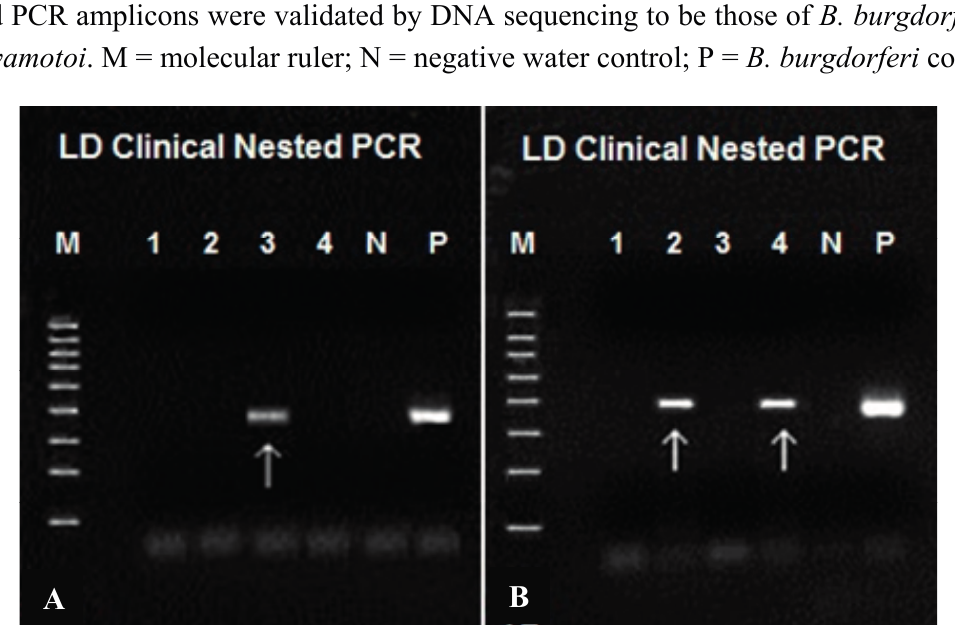
density. The DNA of the spirochetes pelleted from 1 mL of platelet-rich plasma of the patients was extracted and reduced to 100 µL in volume. One µL of the latter crude DNA concentrate was used to initiate each M1/M2 same-nested PCR ×4. ( A ) Only 1 (pointed by arrow) of 4 nested PCRs showed a target DNA amplicon, indicating that the DNA concentrate derived from 1 mL of plasma contained ~25 copies of amplifiable borrelial 16S rDNA; ( B ) Two of 4 nested PCRs generated amplicon bands indicating that the plasma of this patient might contain as many as 50 bacteria per mL; ( C ) One spirochetemic blood sample with high bacterial density (~2000 spirochetes per mL in this sample) showing an amplicon band in all 4 nested PCRs (HBD), compared with 3 negative samples (Cases 1–3). All nested PCR amplicons were validated by DNA sequencing to be those of B. burgdorferi